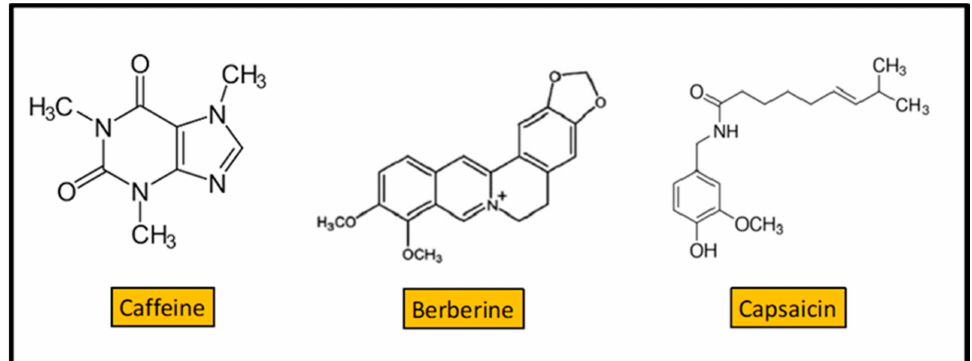
Figure 7. Structure of 3 alkaloids: caffeine, berberine, and